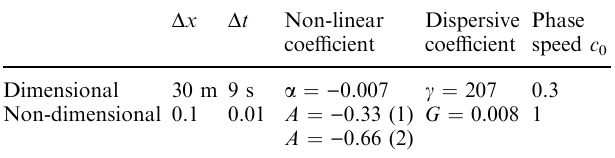
Table 3. Parameters of the non-linear evolution